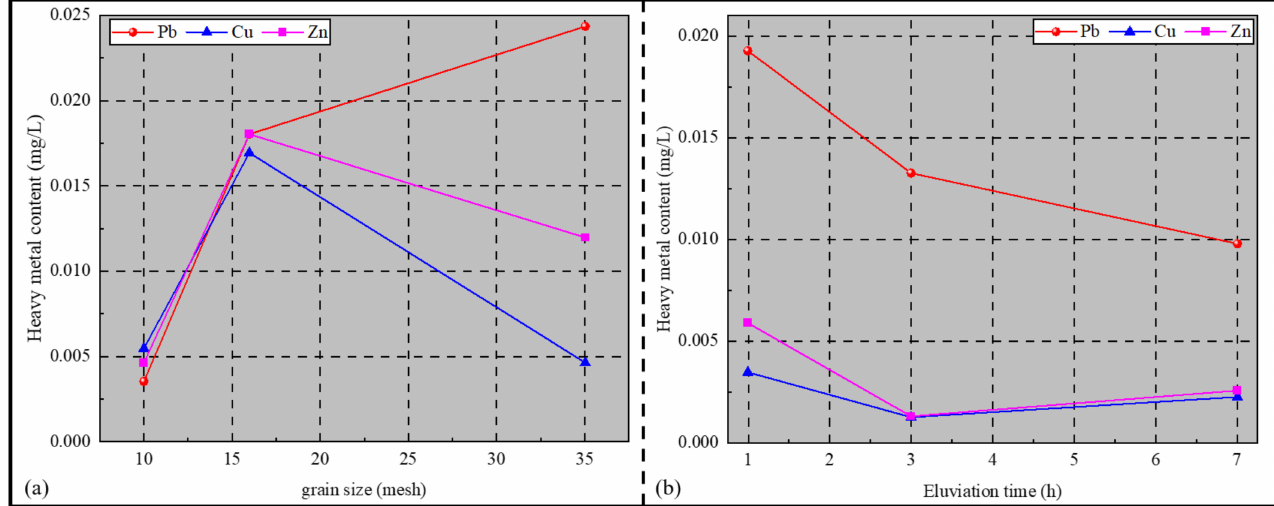
Figure 9. Dynamic eluviation test results: ( a ) Heavy metal content versus grain size curve, ( b ) Heavy metal content versus eluviation time